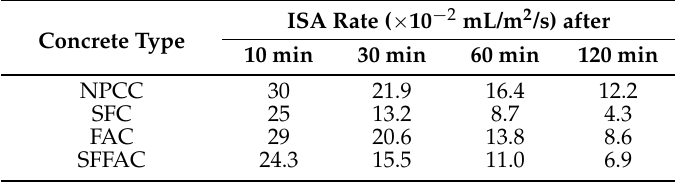
Table 3. Initial surface absorption of different concretes.